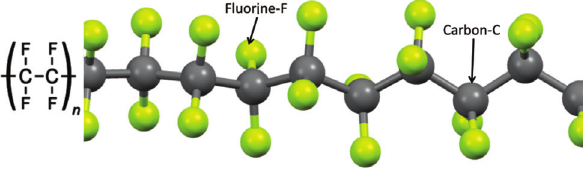
Figure 1 The molecular compound and ball-stick model of